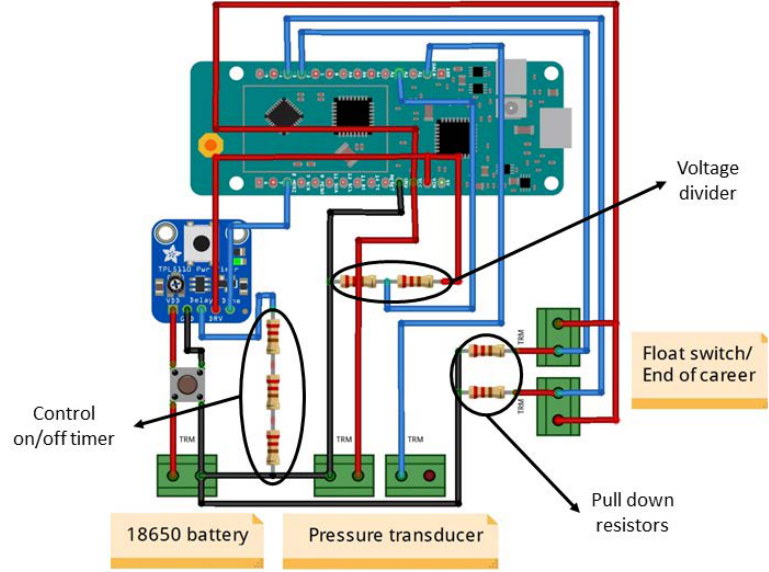
Figure 6. Prototype printed circuit board (PCB) wiring diagram.